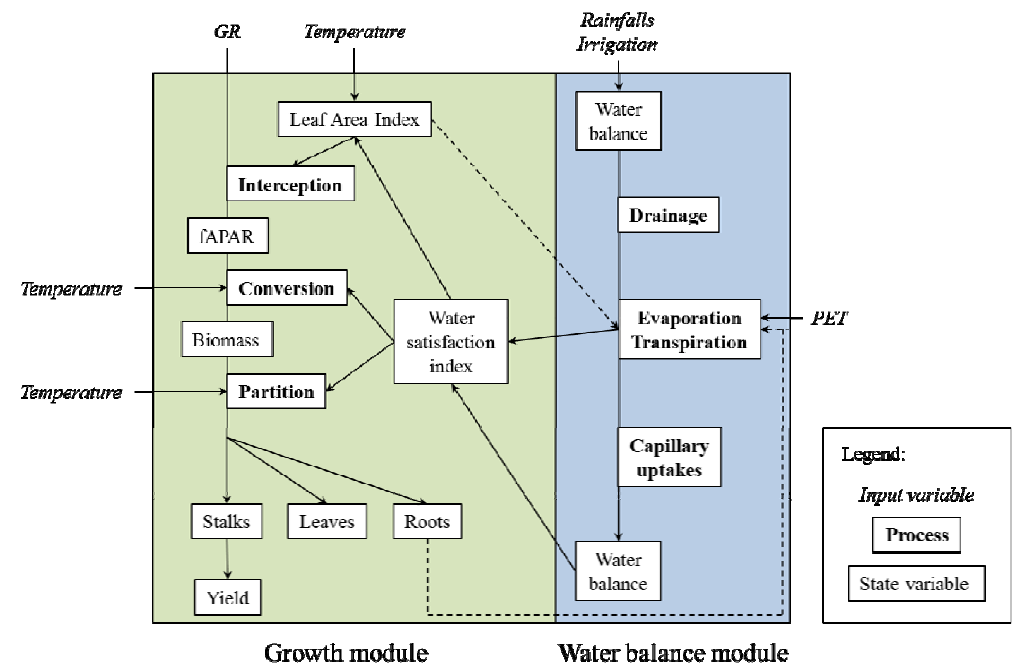
Figure 3. Simplified organization chart of MOSICAS. Adapted from